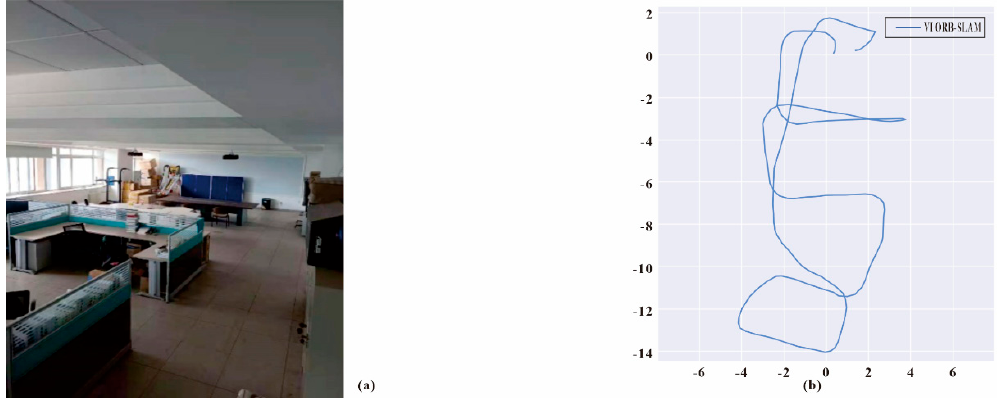
Figure 4. The laboratory environment scene; ( a ) actual scene, ( b ) schematic diagram.